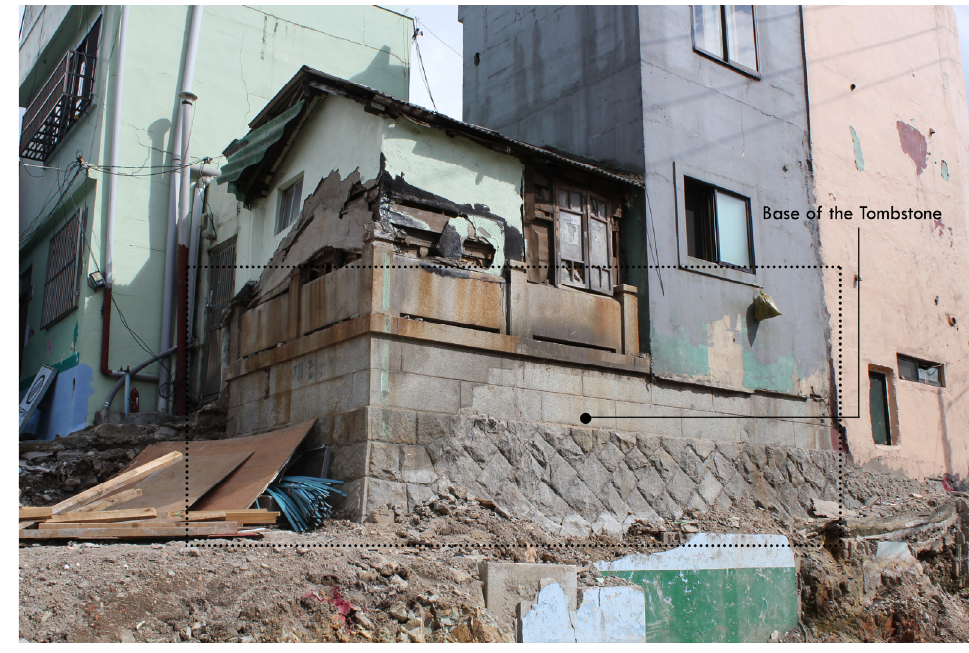
Figure 5. House constructed on a tombstone base.